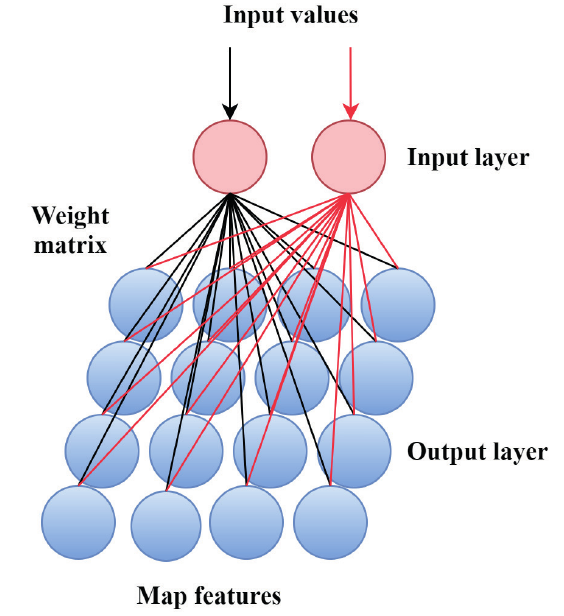
Figure 2. SOM two-level architecture. Figure 3. Flowchart of